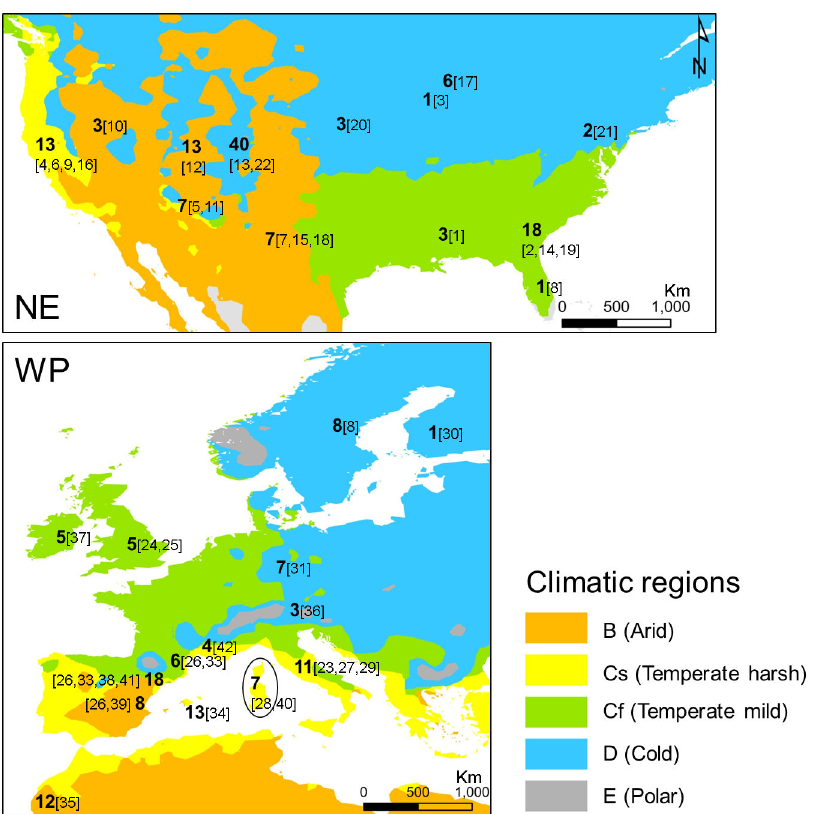
Figure 2. Map showing the number and approximate location of the 225 seasonal wetlands considered in the meta- analysis (bolded) and the corresponding source in Table A in File S1 (in brackets). The climatic regions according to Köppen classification are shown. For details about each study, see Table A in File S1. NE = Nearctic, WP = Western Palearctic. doi: